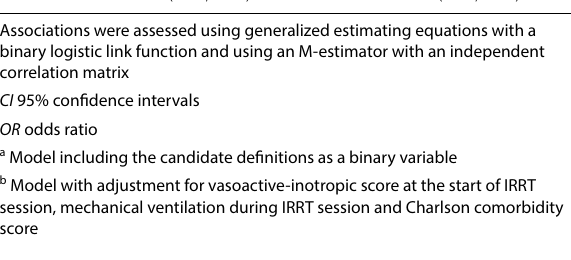
Table 4 Variables associated with intra‑dialytic hypotension (using Definition 2A)